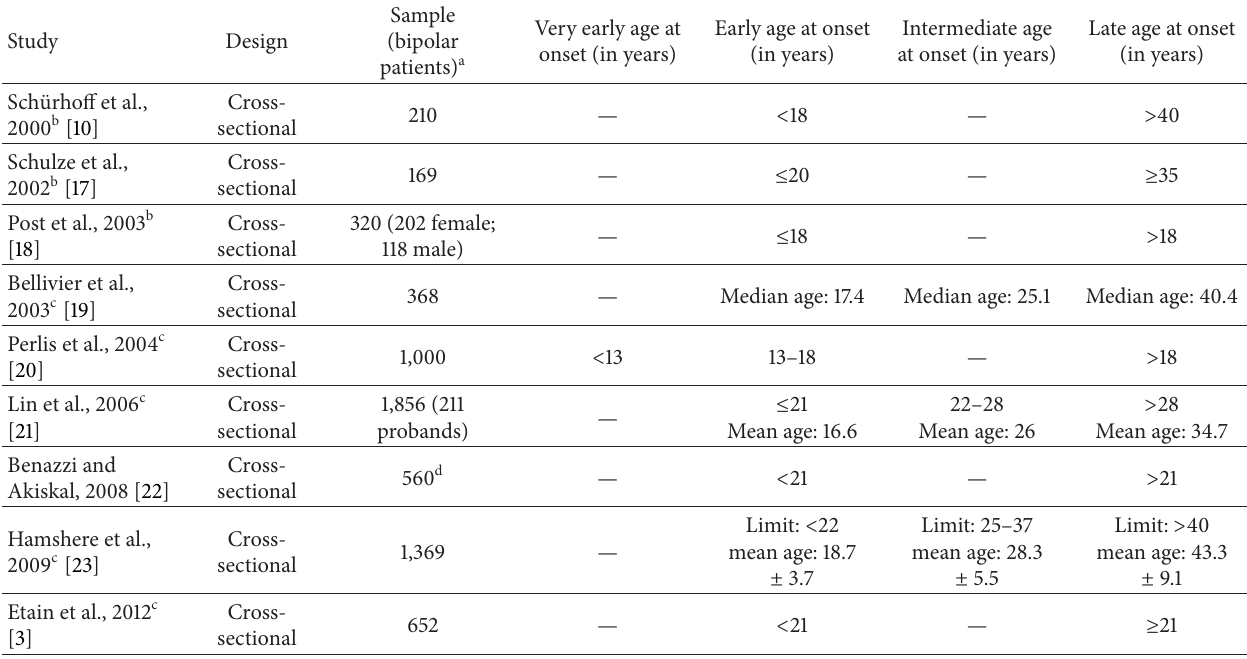
Table 2: Definitions of age at onset of bipolar